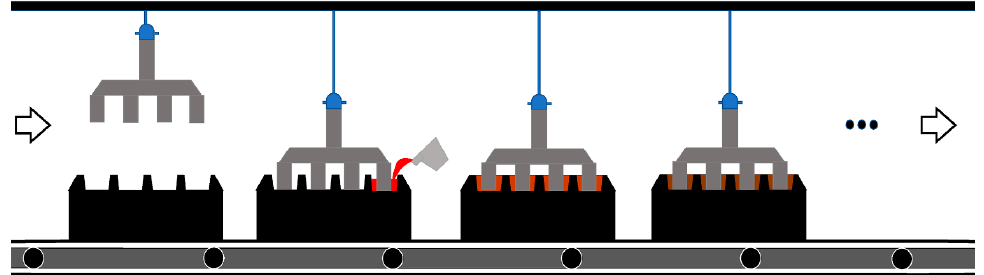
Figure 1. The schematic picture of rodding process in a smelter in China.